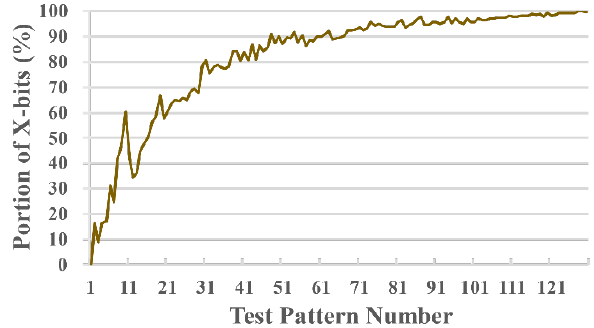
Figure 1. Portion of the X-bits in ISCAS benchmark s38584 [29].